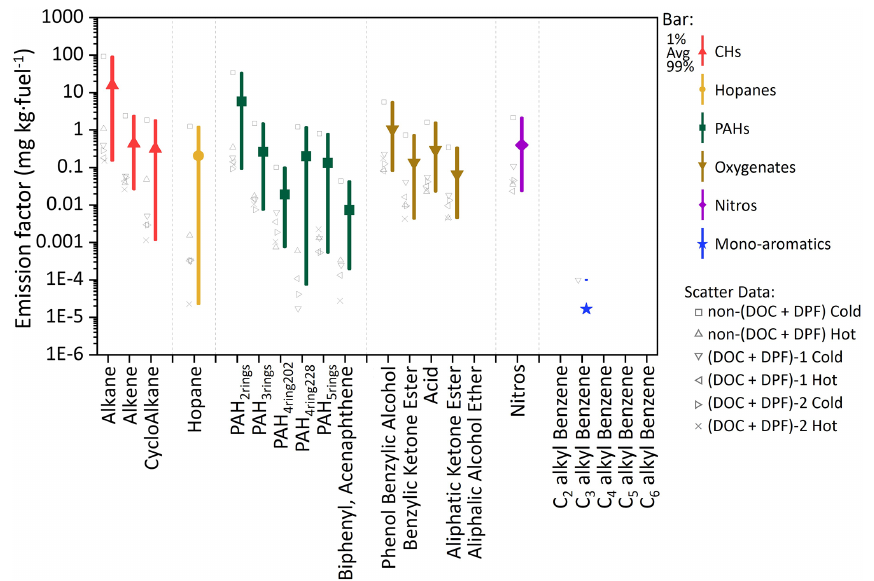
Figure 1. The measured EFs (mgkg − 1 of fuel) of the 21 categories of HDDV-emitted I/SVOCs in the particle phase. Colored bars and colored/shaped scatters represent different organic species and driving cycles, respectively. The scatter points on the left side of the bars represent the averaged EFs measured from different driving conditions or test vehicles. The square dots in the middle of each bar denote the average value, and the lower and upper boundaries of the bar denote the 1st and 99th percentiles of the values,